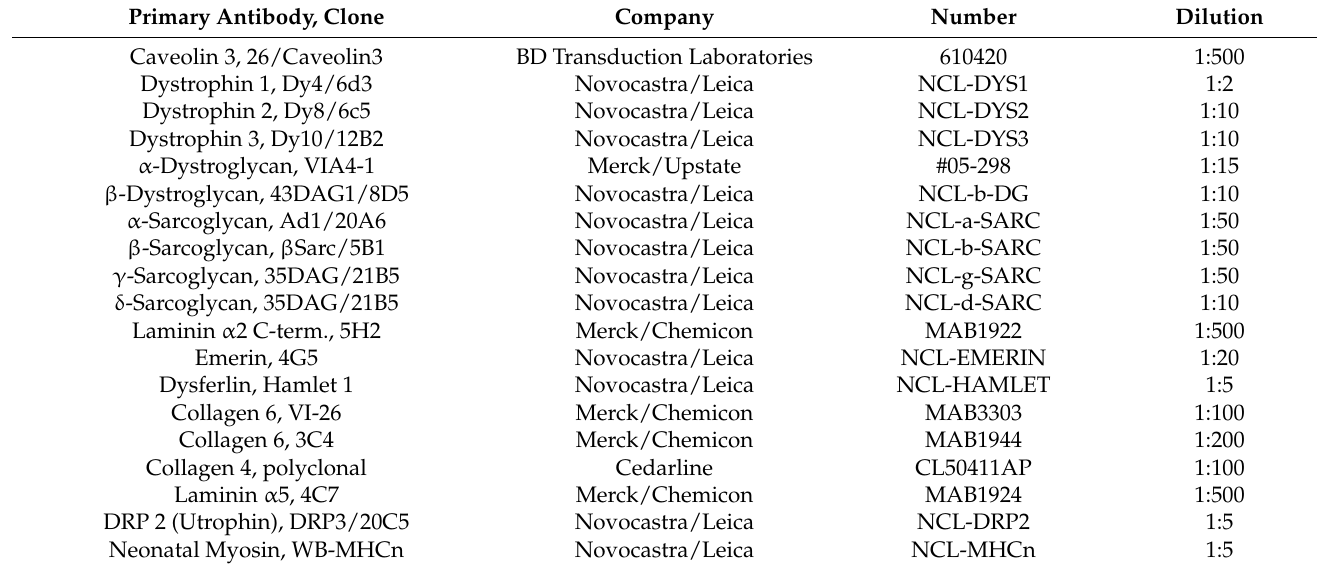
Table 3. Primary antibodies used in